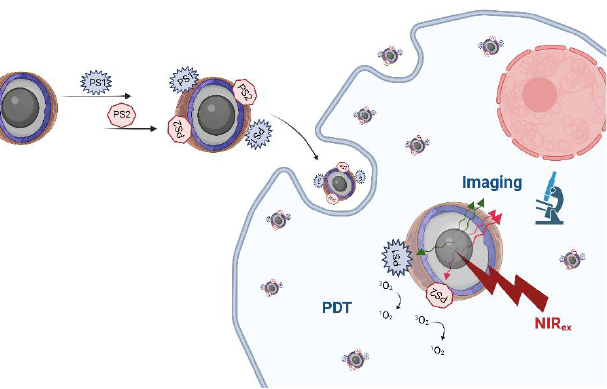
Figure 5. Illustration of the combination of two PSs in UCNPs for imaging and anticancer PDT. Created with BioRender.com.